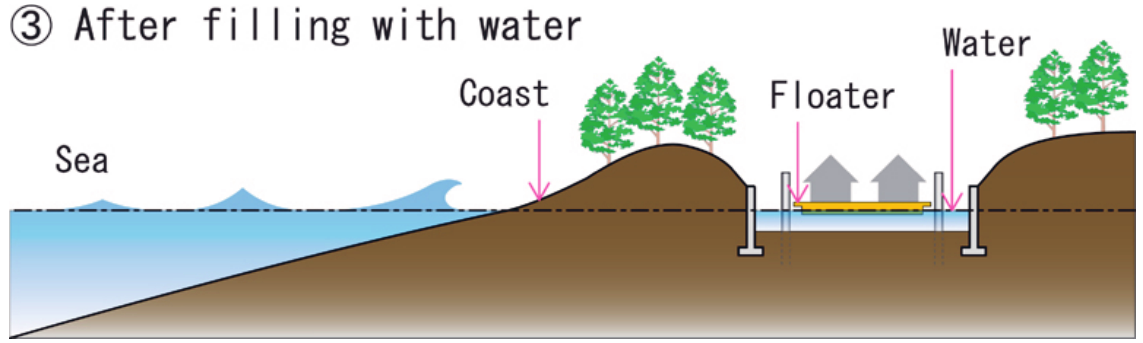
Figure 7. Final view of the floating platform in the man-made